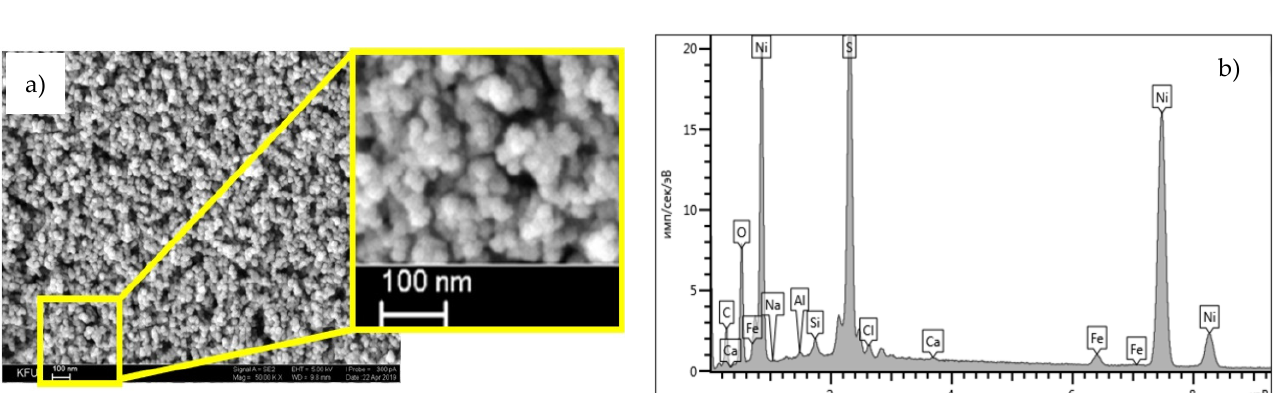
Figure 2. SEM image of catalyst particles ( a ) and their surface composition ( b ). The distribution of elements in the catalysts isolated after thermo-catalytic treatment for 12 h are presented in Figure 3. The results indicate the ambiguous behavior in the weight compositions of Ni, C, O, S elements. During various thermo-catalytic treatment duration, the active form of the catalyst was observed in the form of nickel sulfide. The adsorption of coke-like compounds on the catalyst nanoparticles results to the increase in the content of carbon element. The content of Na and Al metals as well as non-metals such as O, Si, and Cl, which exist in the composition of rocks, were increased.